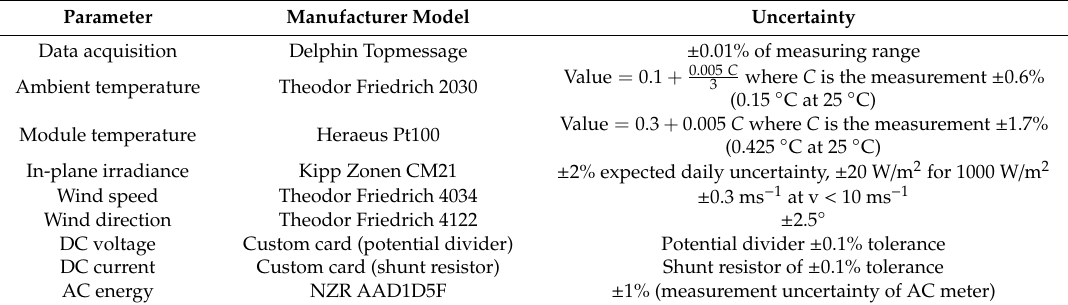
Table 2. Technical information of data acquisition system and